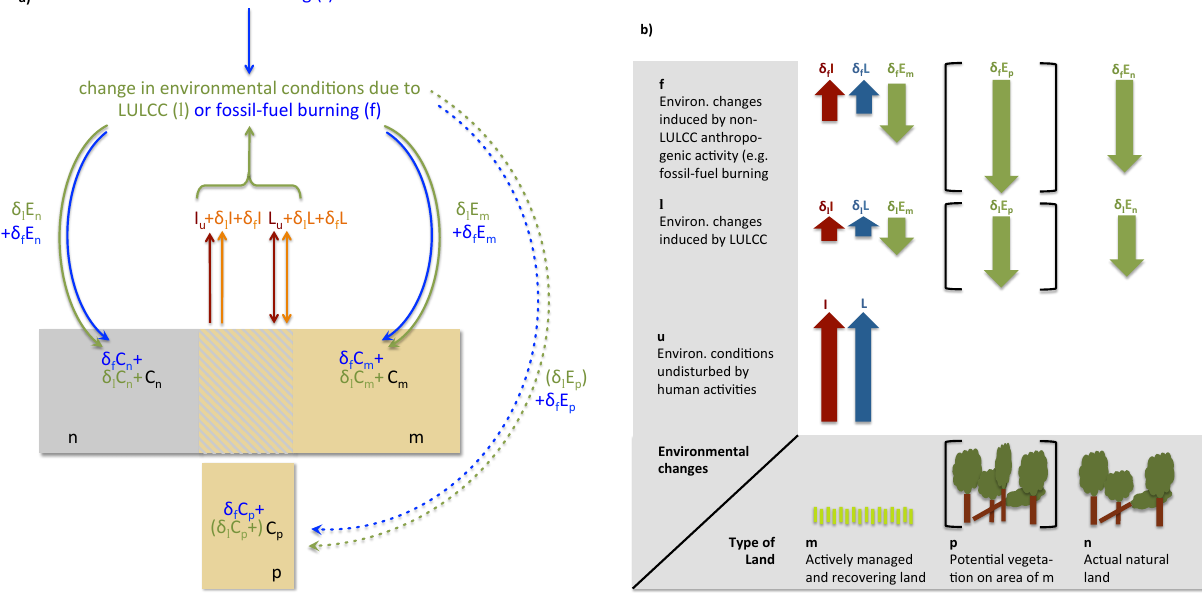
Fig. 1. Conceptual definition of land–atmosphere carbon fluxes representing all individual fluxes included in different model approaches to quantify the net LULCC flux. Note that no approach models every flux. (a) Illustration of the effects of LULCC and changing environmental conditions on carbon stocks and fluxes. Colours indicate steps in the causal chain set off by a LULCC event. Black: initial state. Dark red: effects of changes in vegetation distribution due to LULCC (dashed rectangle being transformed from actual natural to managed land) on carbon stocks (“direct LULCC effects”). Green: feedbacks of LULCC via environmental conditions on carbon stocks and fluxes. The LULCC feedback is put in parenthesis for potential natural vegetation because in coupled (ESM) simulations this flux will not occur due to the absence of LULCC; however, in uncoupled (DGVM) simulations the atmospheric CO 2 concentration can be prescribed so as to include both LULCC and fossil-fuel effects, and δ l E p occurs. Orange: subsequent changes in carbon fluxes from changes in vegetation due to LULCC-induced environmental changes (“indirect LULCC effects”). Blue: changes in carbon fluxes due to other externally induced environmental changes, primarily due to fossil-fuel burning. (b) Summary of carbon fluxes related to LULCC from (a) , distinguished by the environmental conditions under which they occur ( u : undisturbed environmental conditions; l : LULCC-induced changes in environmental conditions; f : other externally induced changes in environmental conditions, primarily due to fossil-fuel burning) and by the vegetation state of the area the fluxes occur on ( m : managed land; n : actual natural land; p : potential vegetation on the area of managed land). Note that in an individual model simulation, the vegetation state will be composed of either actual natural and managed land, when LULCC is accounted for, or actual natural and potential natural (instead of managed) land, when no LULCC is considered; because the net LULCC flux is derived as the difference between with- and without-LULCC simulations, fluxes on potential natural vegetation occur only as subtrahend, marked by square brackets here. I : instantaneous emissions from LULCC, L : legacy flux; E : changes in carbon stocks as a response to environmental changes. δ u fluxes are 0 by definition and not depicted. Note that all fluxes apart from instantaneous emissions ( I ) may act as a source or sink of carbon on land; the arrow directions indicated here loosely refer to historical evidence for global fluxes, but in fact depend on region, assumed scenario of LULCC and environmental conditions, and